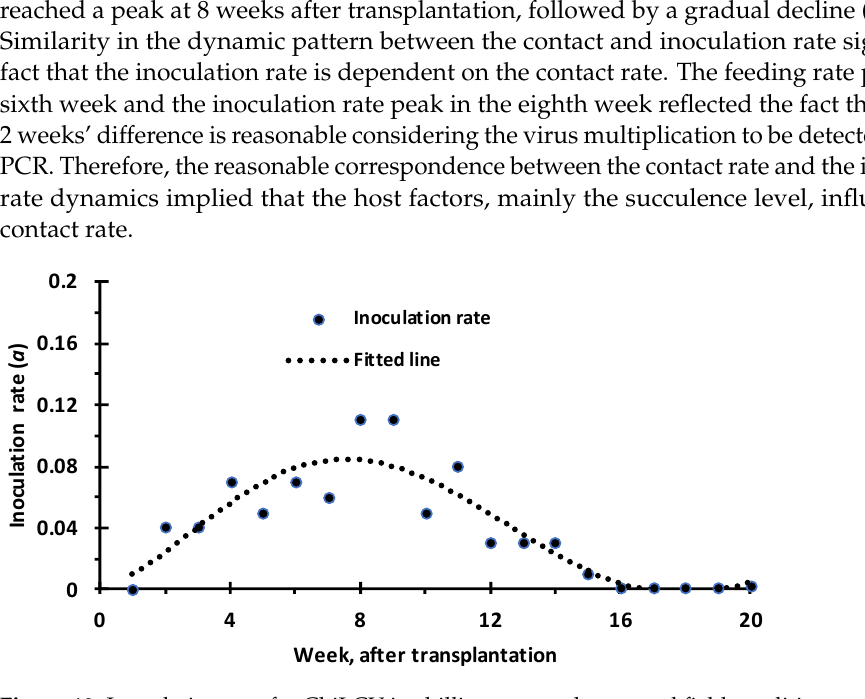
Figure 10. Inoculation rate for ChiLCV in chilli grown under natural field conditions.